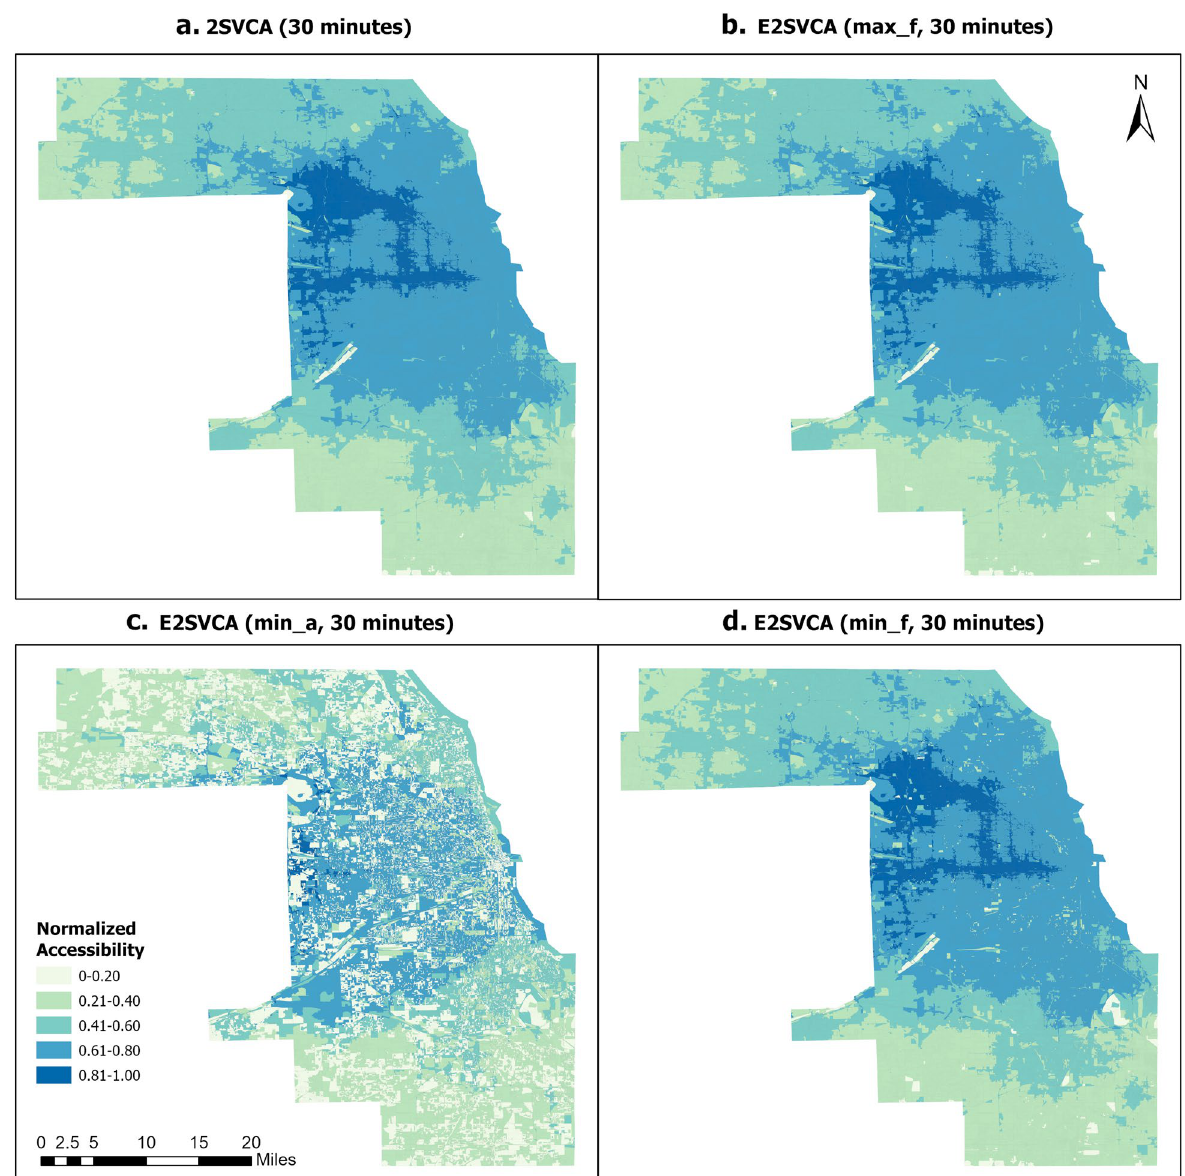
Fig. 5 Normalized 30 min 2SVCA and E2SVCA